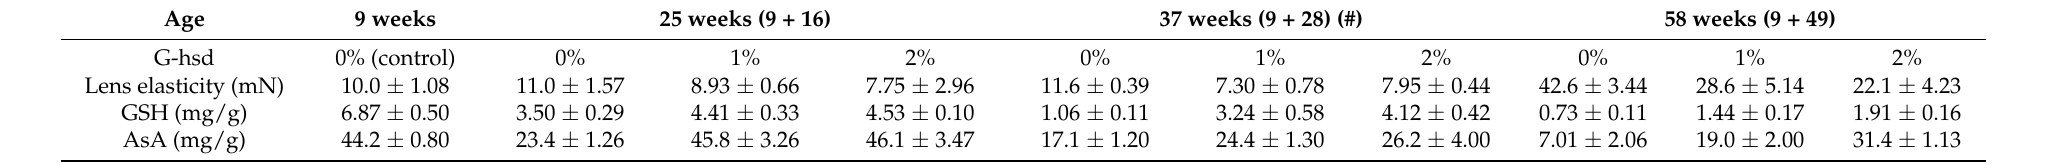
Table 1. The lens elasticity and GSH and Ascorbic Acid (AsA) levels in the lens for 16 weeks, 28 weeks, and 49 weeks consumption of